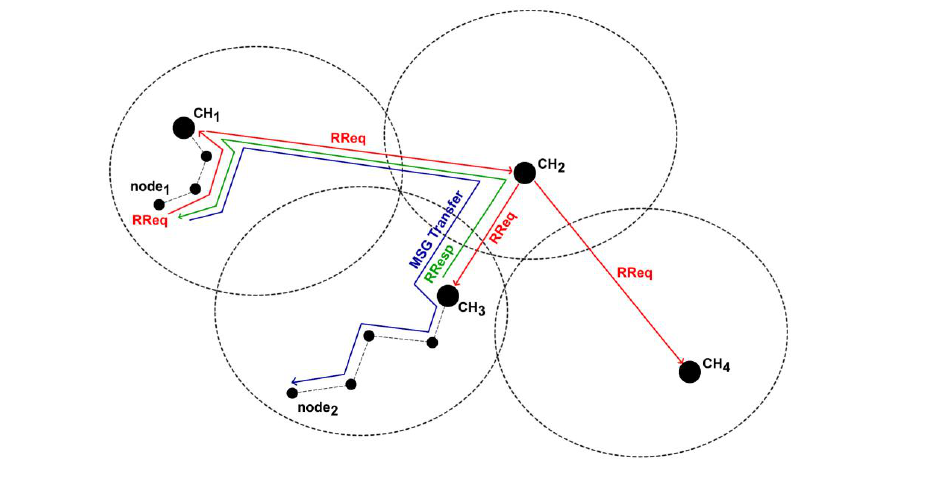
Figure 5. Route Request